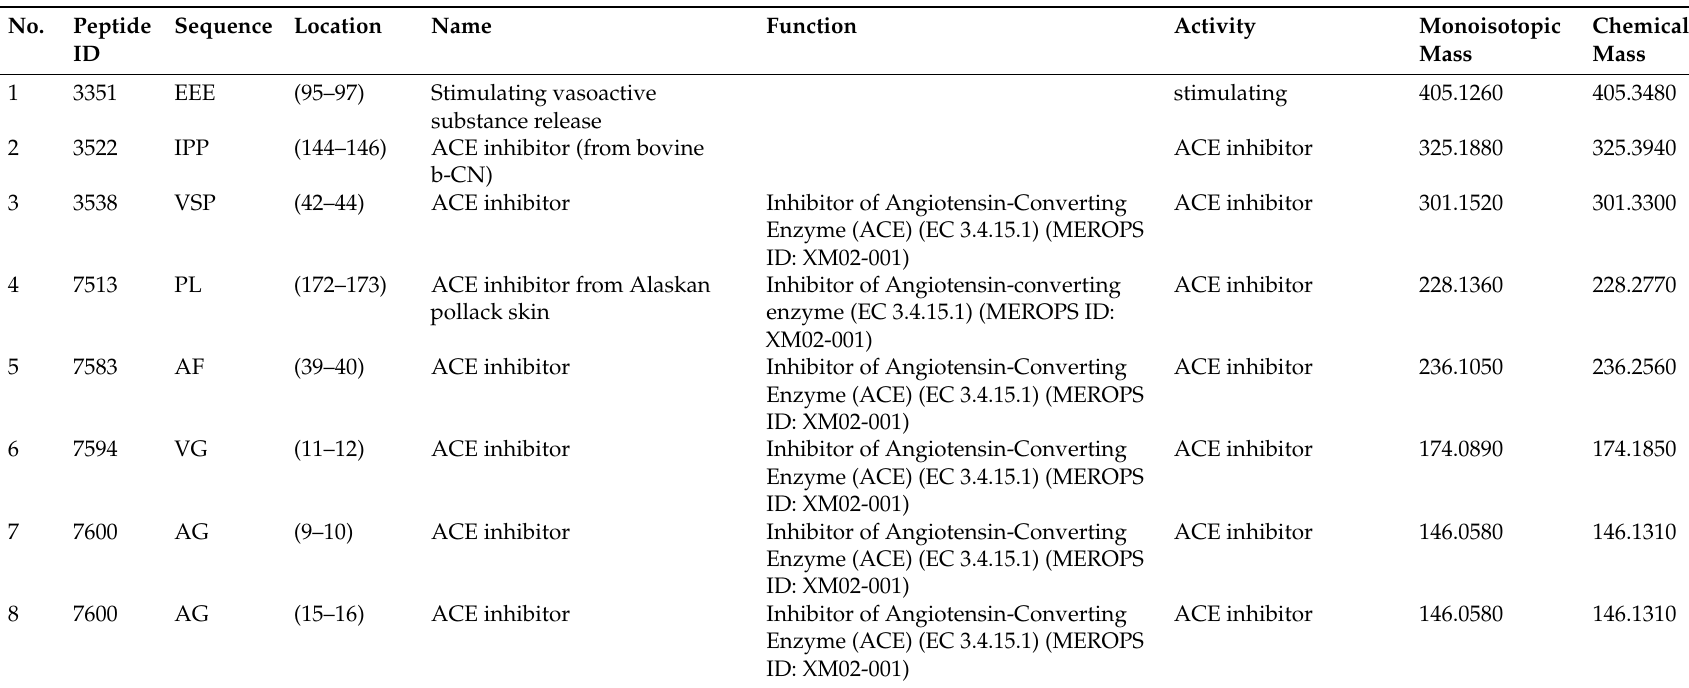
Table A27. Bioactive peptides from RubisCO of Halophila stipulacea . In silico enzymatic cleavage was carried out by using